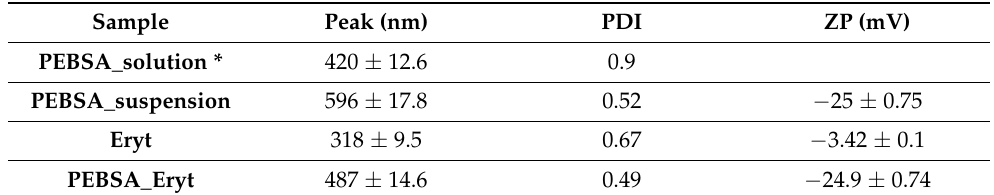
Table 4. Peak mean diameters and PDI values measured by DLS.